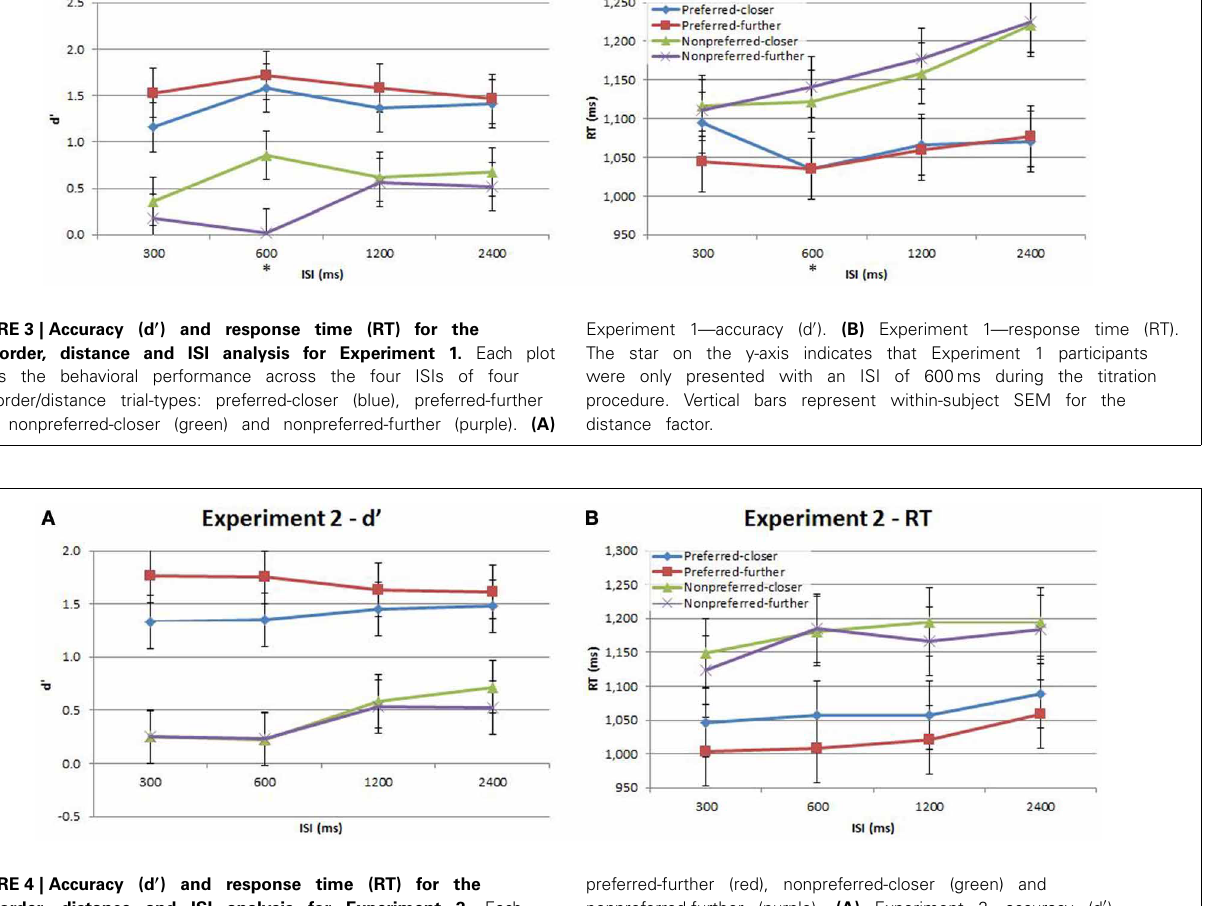
preferred-further (red), nonpreferred-closer (green) and nonpreferred-further (purple). (A) Experiment 2—accuracy (d (cid:2) ). (B) Experiment 2—response time (RT). Vertical bars represent within-subject SEM for the factor of